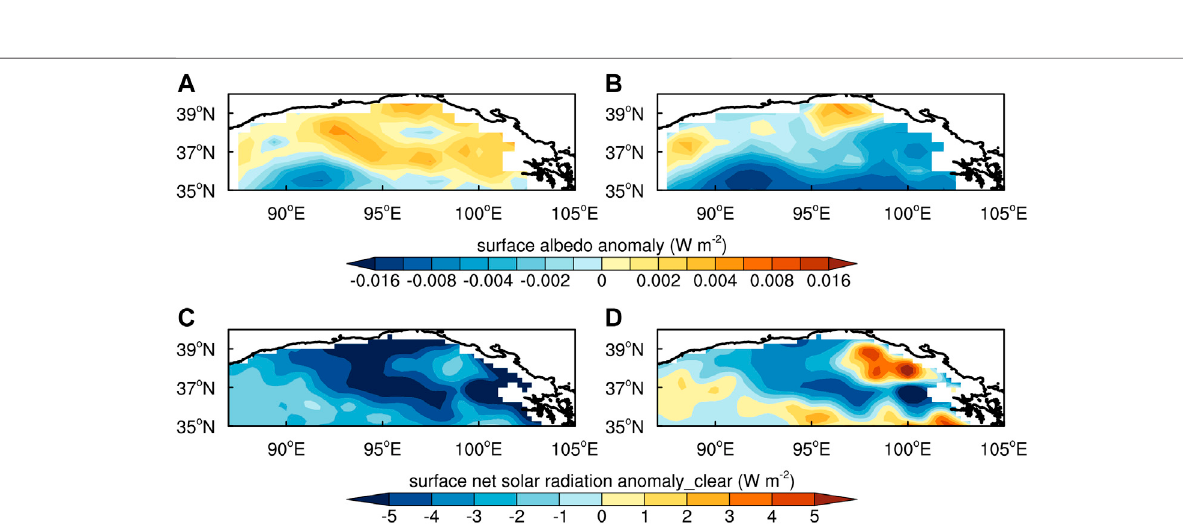
Frontiers in Environmental Science |